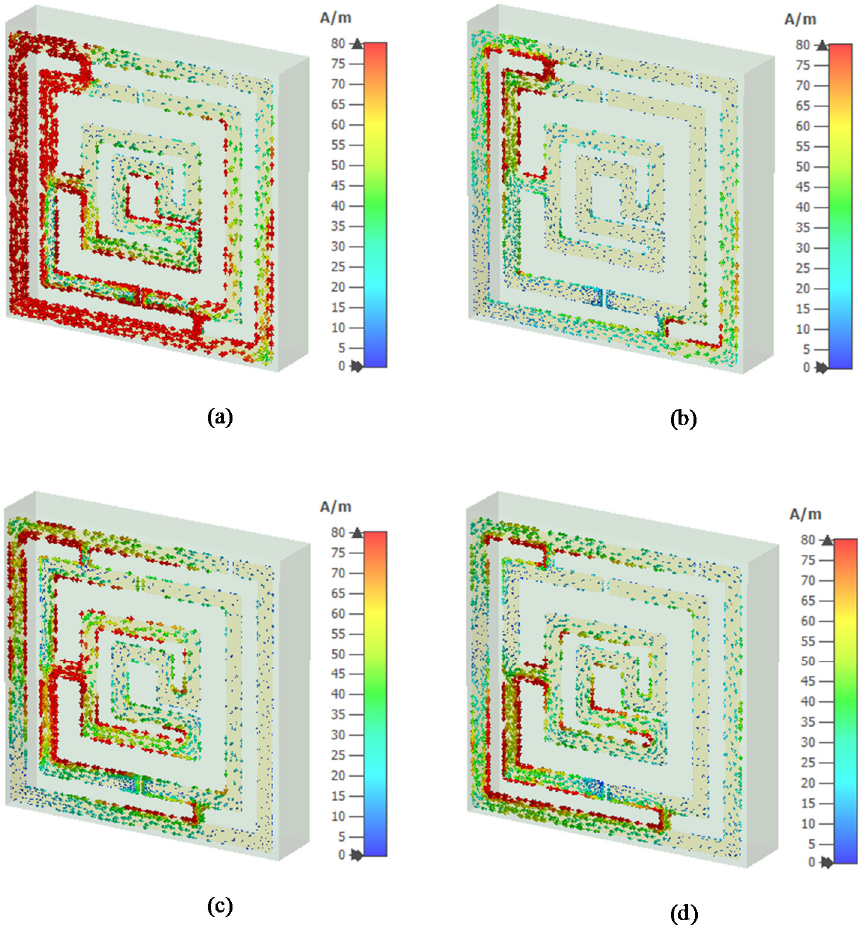
Figure 10. Surface current distribution at ( a ) 2.4 GHz; ( b ) 5.6 GHz; ( c ) 8.9 GHz; ( d ) 11.5 GHz.